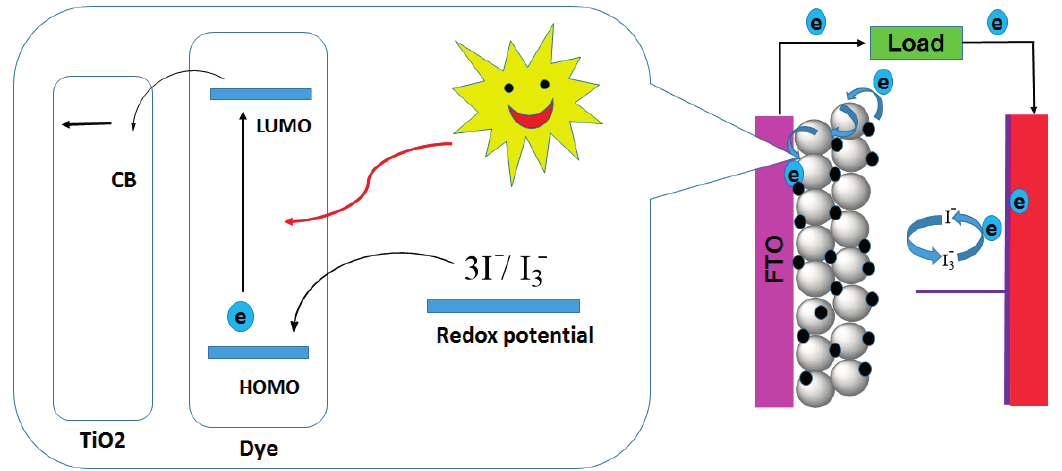
Figure 2. Representation of the construction and operational principle of dye sensitized solar